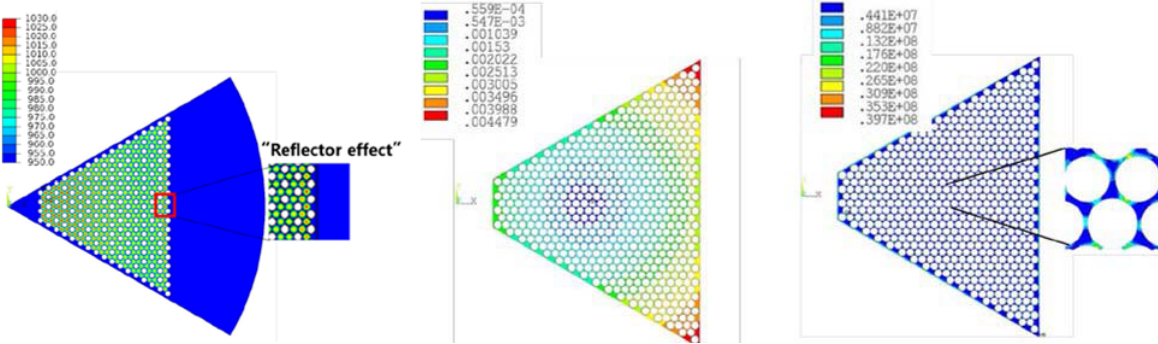
(a) Temperature distribution(units in K) (b) Monolith radial displacement (units in m) (c) monolith Mises stress distribution(units in Pa) Fig. 6 MEGAPOWER temperature distribution and mechanical results after neutronic and thermal- mechanical coupling Table 2 Temperature and stress difference between coupling and non-coupling cases Without N-T/M N-T/M coupling Difference coupling Maxium Fuel Temperature 1023 K 1033 K -10 K Maximum Monolith Temperature 969 K 971 K -2 K Maxium Monolith Stress 37MPa 40 MPa -3